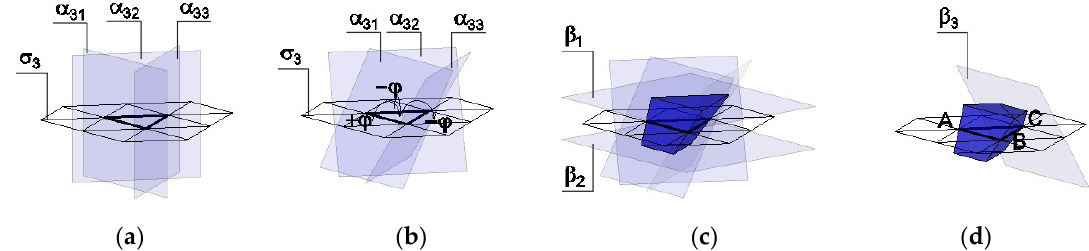
Figure 4. The procedure of modeling a vault component based on a rectangular triangle: (a) establishment of a grid of triangles  3 and insertion the planes  3j perpendicular to it; (b) rotations of the planes  3j ; (c) final determination of a component shape with the use of planes  1 and  2 , (d) cutting off excess component volume using a plane  3